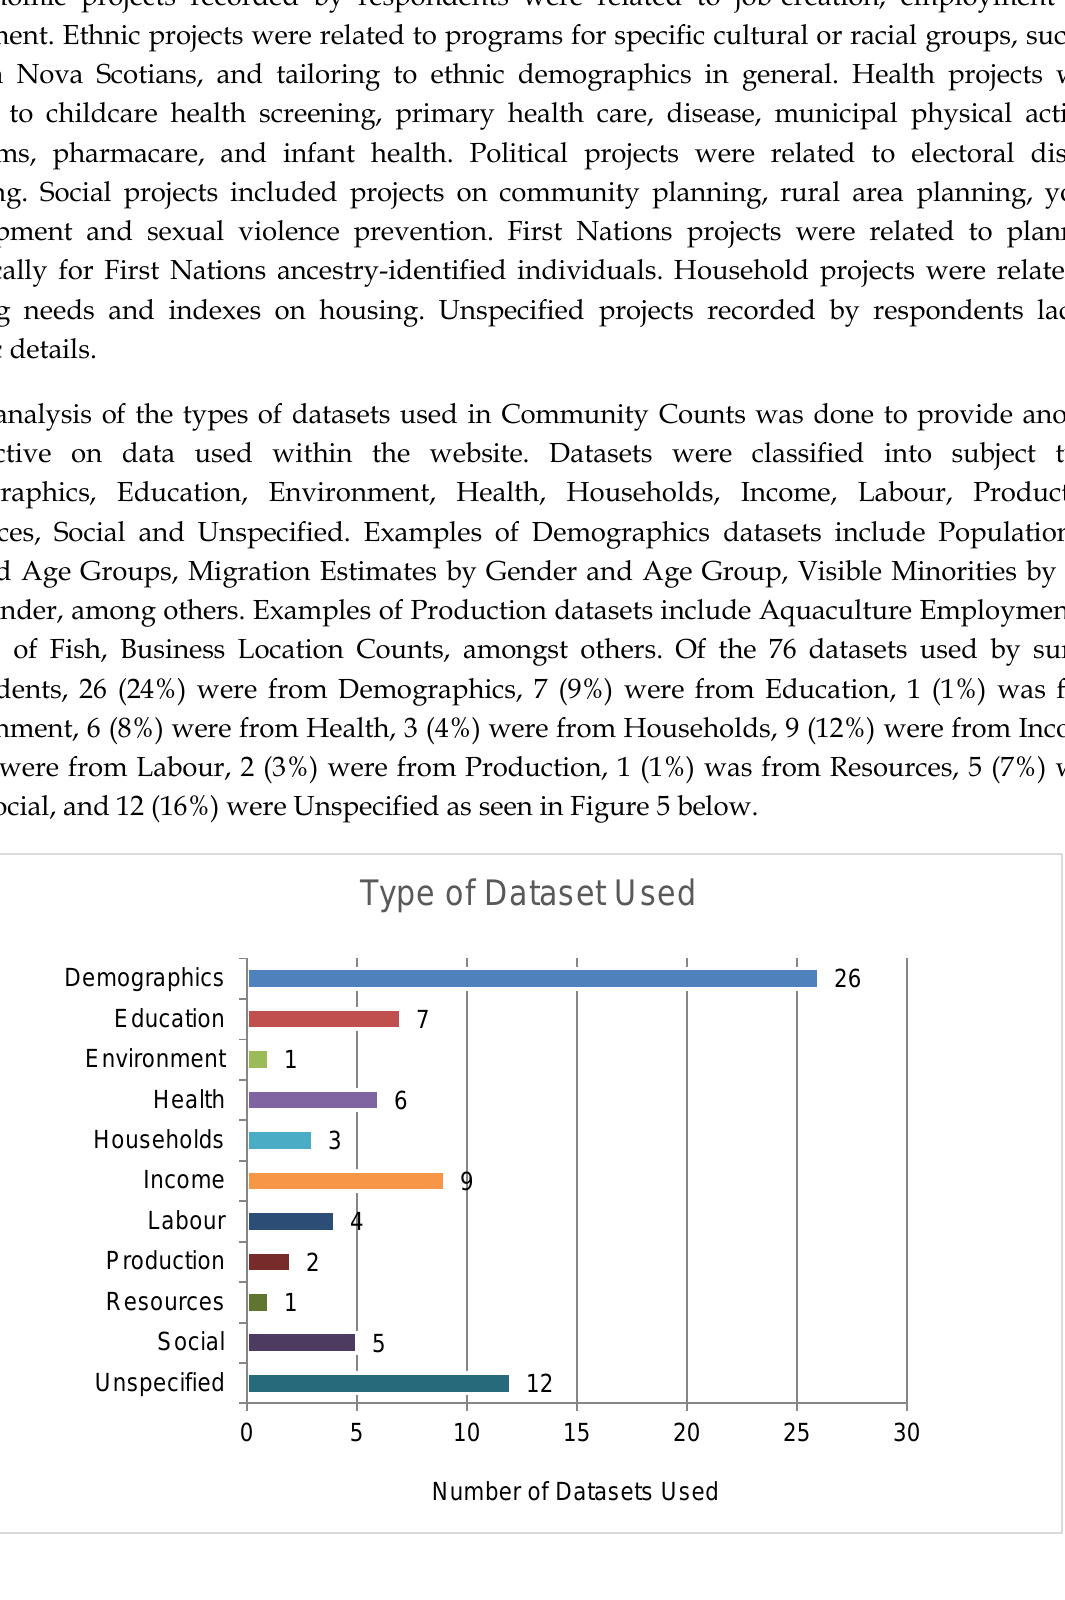
Figure 4: Community Counts Project Types, n = 32 Economic projects recorded by respondents were related to job-creation, employment and investment. Ethnic projects were related to programs for specific cultural or racial groups, such as African Nova Scotians, and tailoring to ethnic demographics in general. Health projects were related to childcare health screening, primary health care, disease, municipal physical activity programs, pharmacare, and infant health. Political projects were related to electoral district planning. Social projects included projects on community planning, rural area planning, youth development and sexual violence prevention. First Nations projects were related to planning specifically for First Nations ancestry-identified individuals. Household projects were related to housing needs and indexes on housing. Unspecified projects recorded by respondents lacked specific